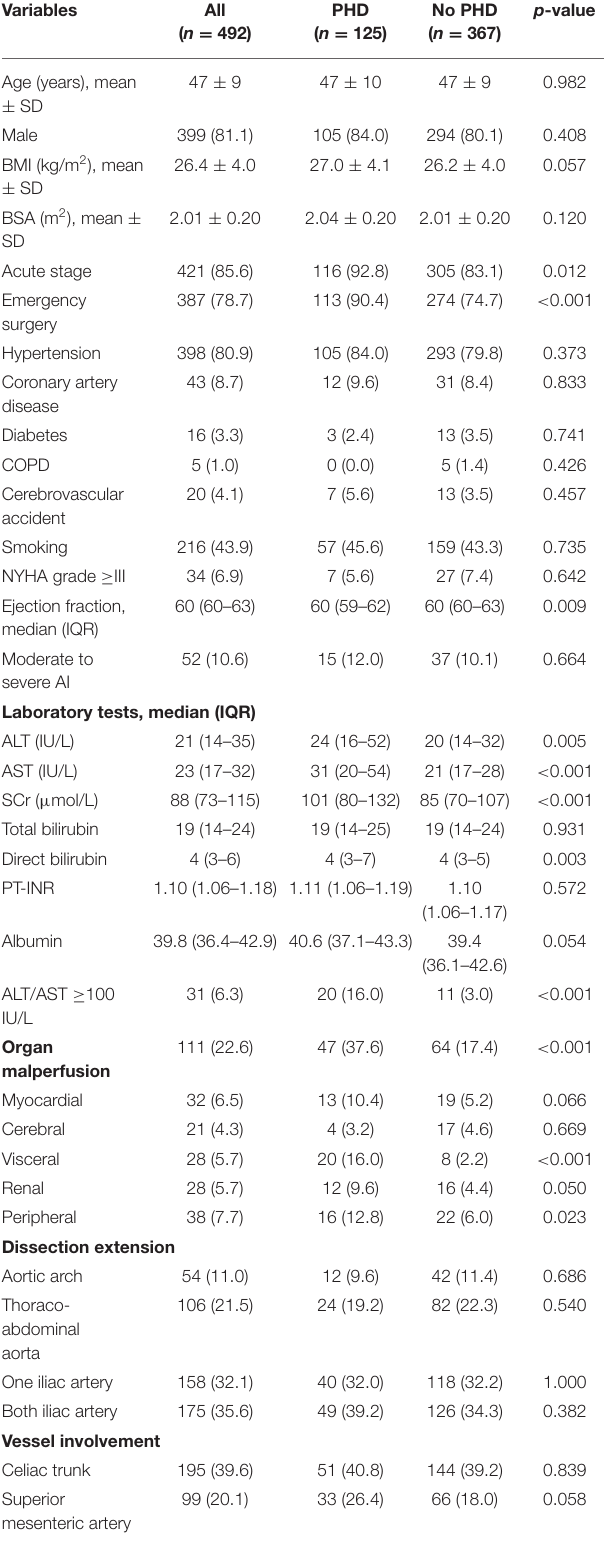
TABLE 1 | Preoperative